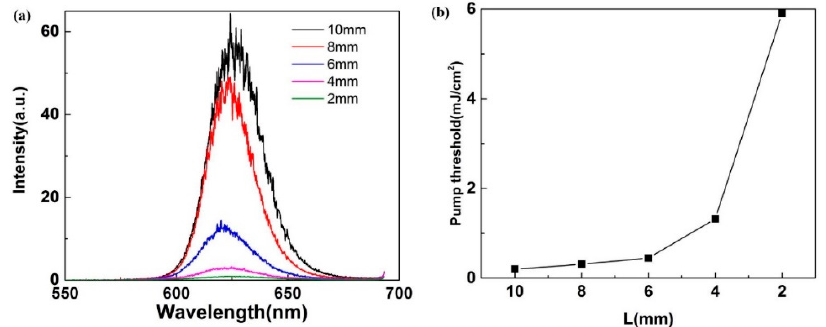
Figure 5. ( a ) The emission spectrum of the NPDDNLC sample as a function of the length (L) of pump stripe, when the pump energy density is 0.52 mJ/cm 2 . ( b ) The pump threshold of the NPDDNLC sample as a function of the length of pump stripe.